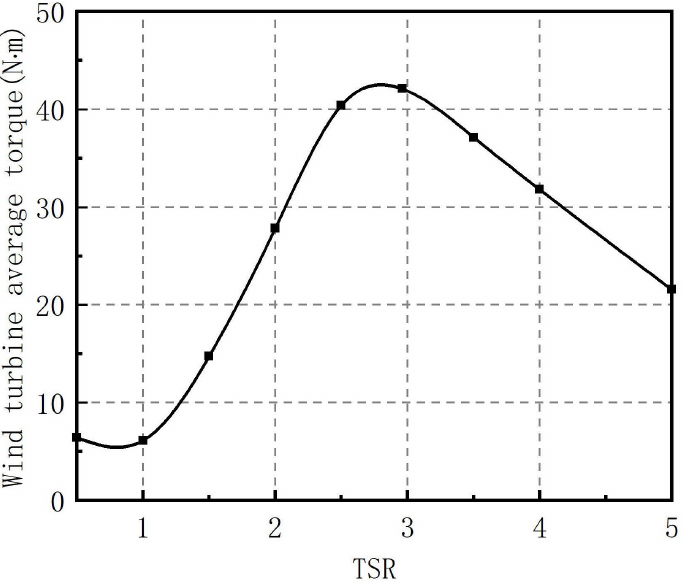
Figure 22. Average torque curve with blade tip speed